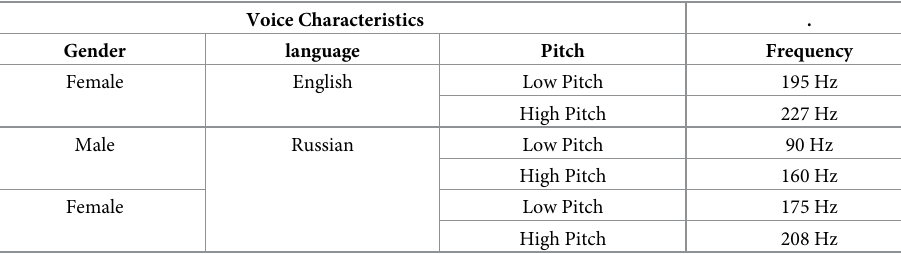
Table 1. Frequency of each voice group generated for experiment 2.